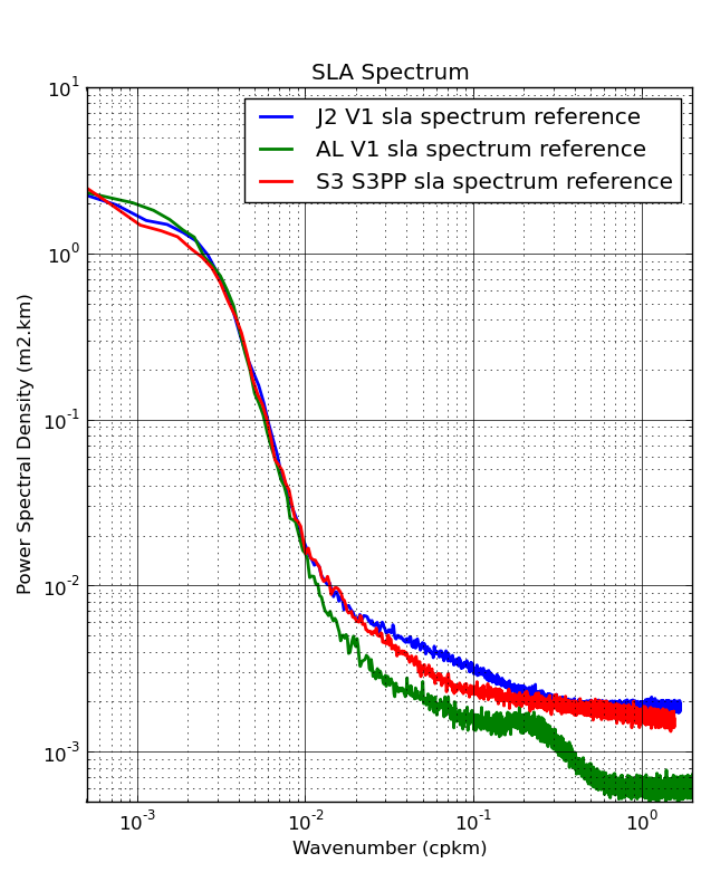
Figure 13. SARAL/AltiKa’s SLA power spectrum (green) compared to Jason-2 (blue) and Sentinel-3A (red), with adapted editing and [31] correction for the three